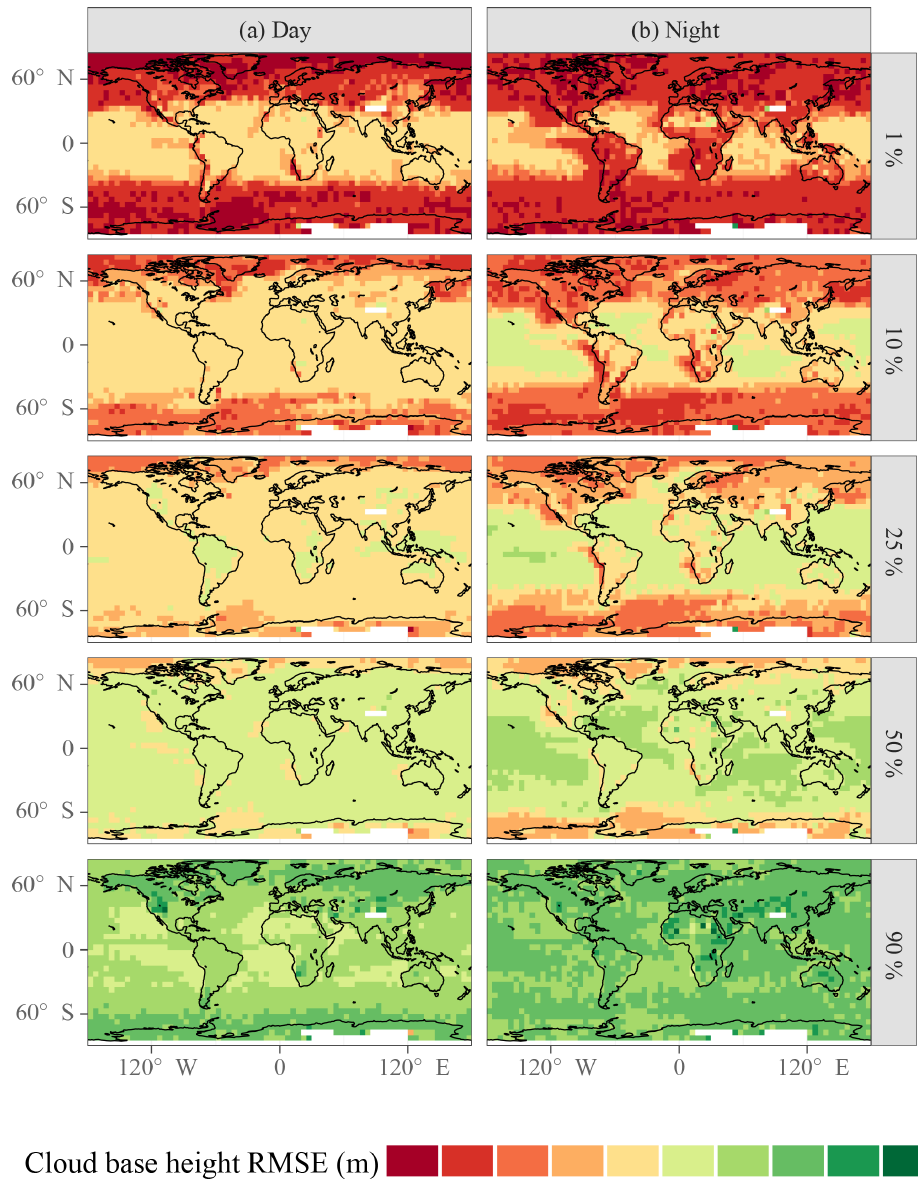
Figure 13. Cloud base uncertainty quantiles. Statistics are calculated within each 5 ◦ × 5 ◦ latitude–longitude box. Panels (a) and (b) show statistics of daytime and nighttime retrievals, respectively; daytime and nighttime are defined by the CALIOP VFM